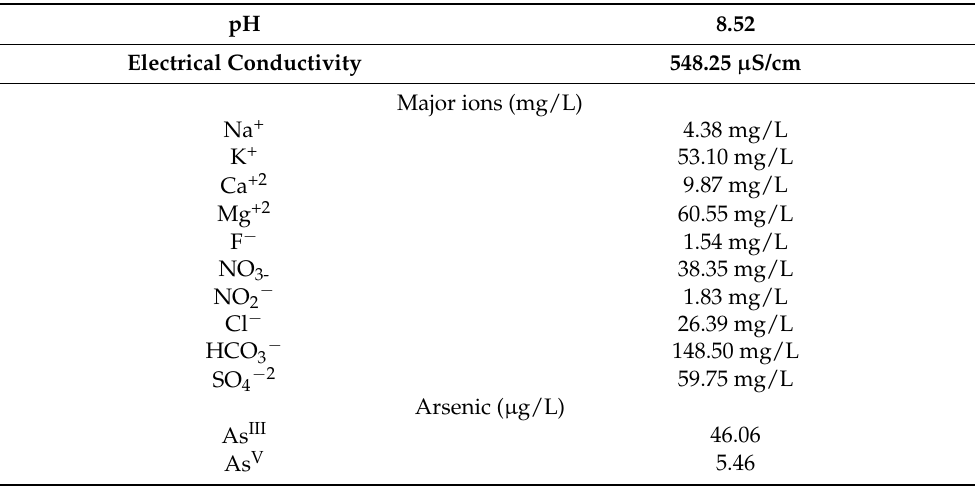
Table 2. Groundwater physicochemical characterization.